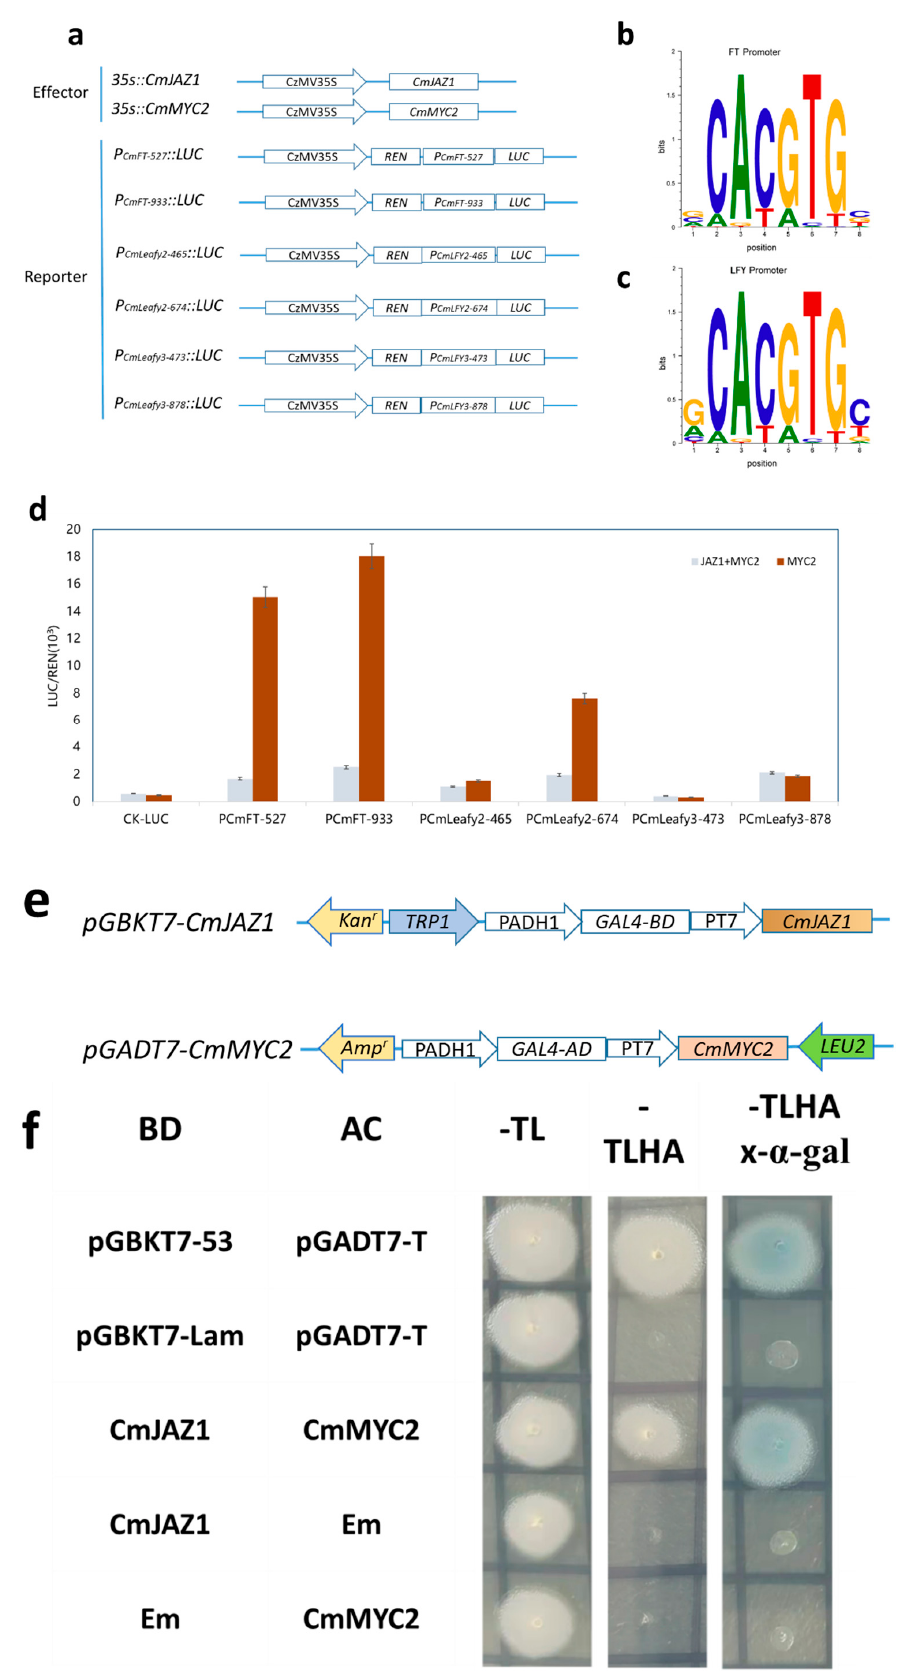
Figure 10. In vitro validation of interaction between CmMYC2 and CmJAZ1 in regulating FT and